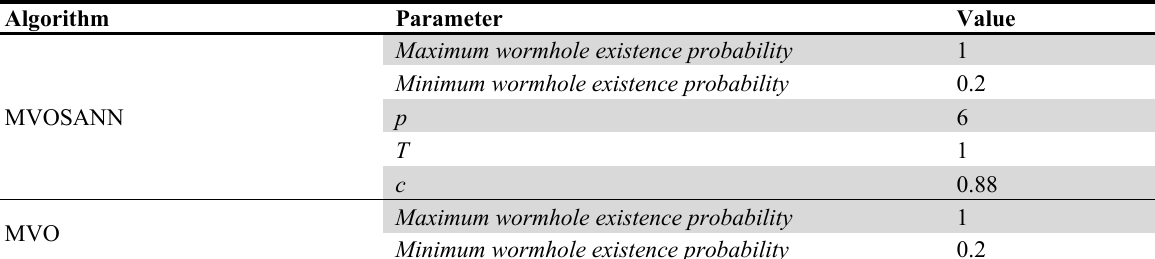
Parameters and values of MVOSANN and other algorithms Algorithm